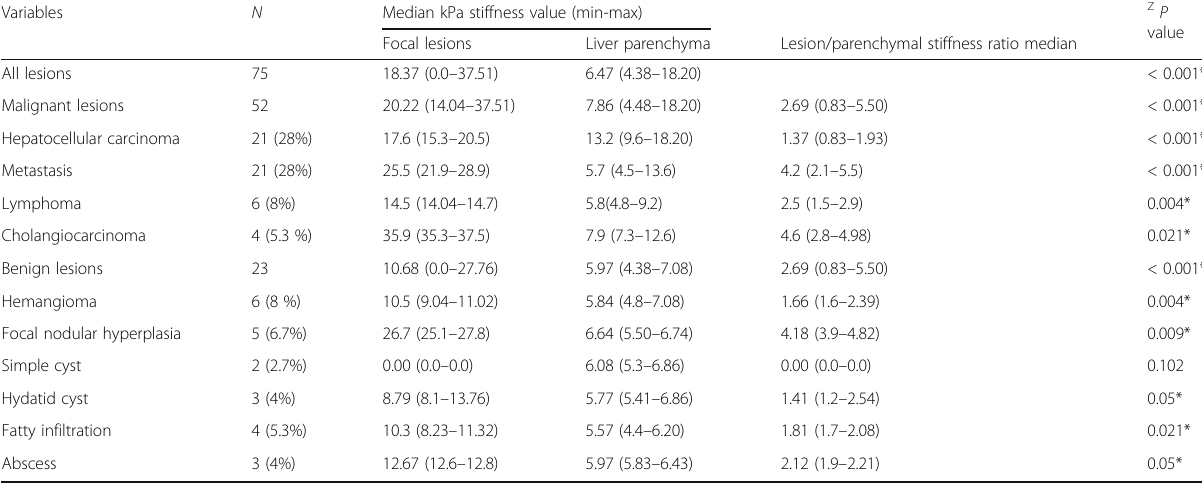
Table 5 Shear wave elastography median (min-max) stiffness values (kPa) of different categories of benign and malignant hepatic focal lesions, and the surrounding liver parenchyma